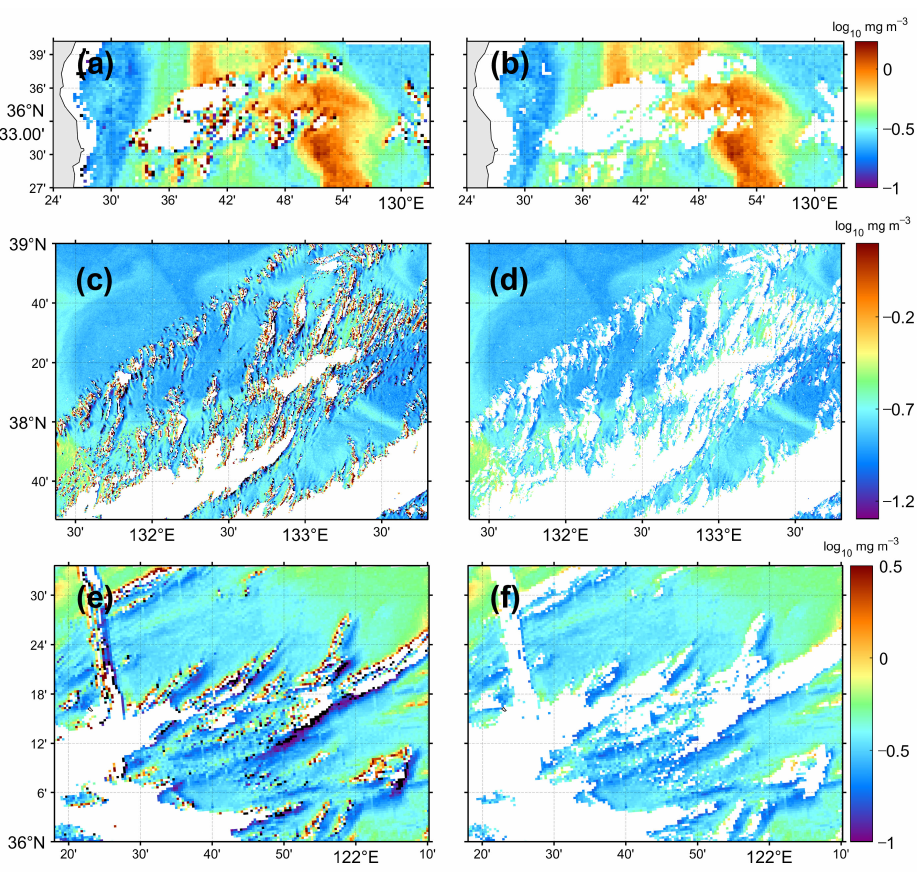
Figure 9. Examples of removal results of erroneous chlorophyll- a concentration pixels ( a ), ( c ), ( e ) before and ( b ), ( d ), and ( f ) after speckle removal procedure of each GOCI image from 3 June 2015. The frequency distribution of the erroneous pixels estimated from the speckle-removal process was obtained as a percentage of the total chl- a observations in 2015 (Figure